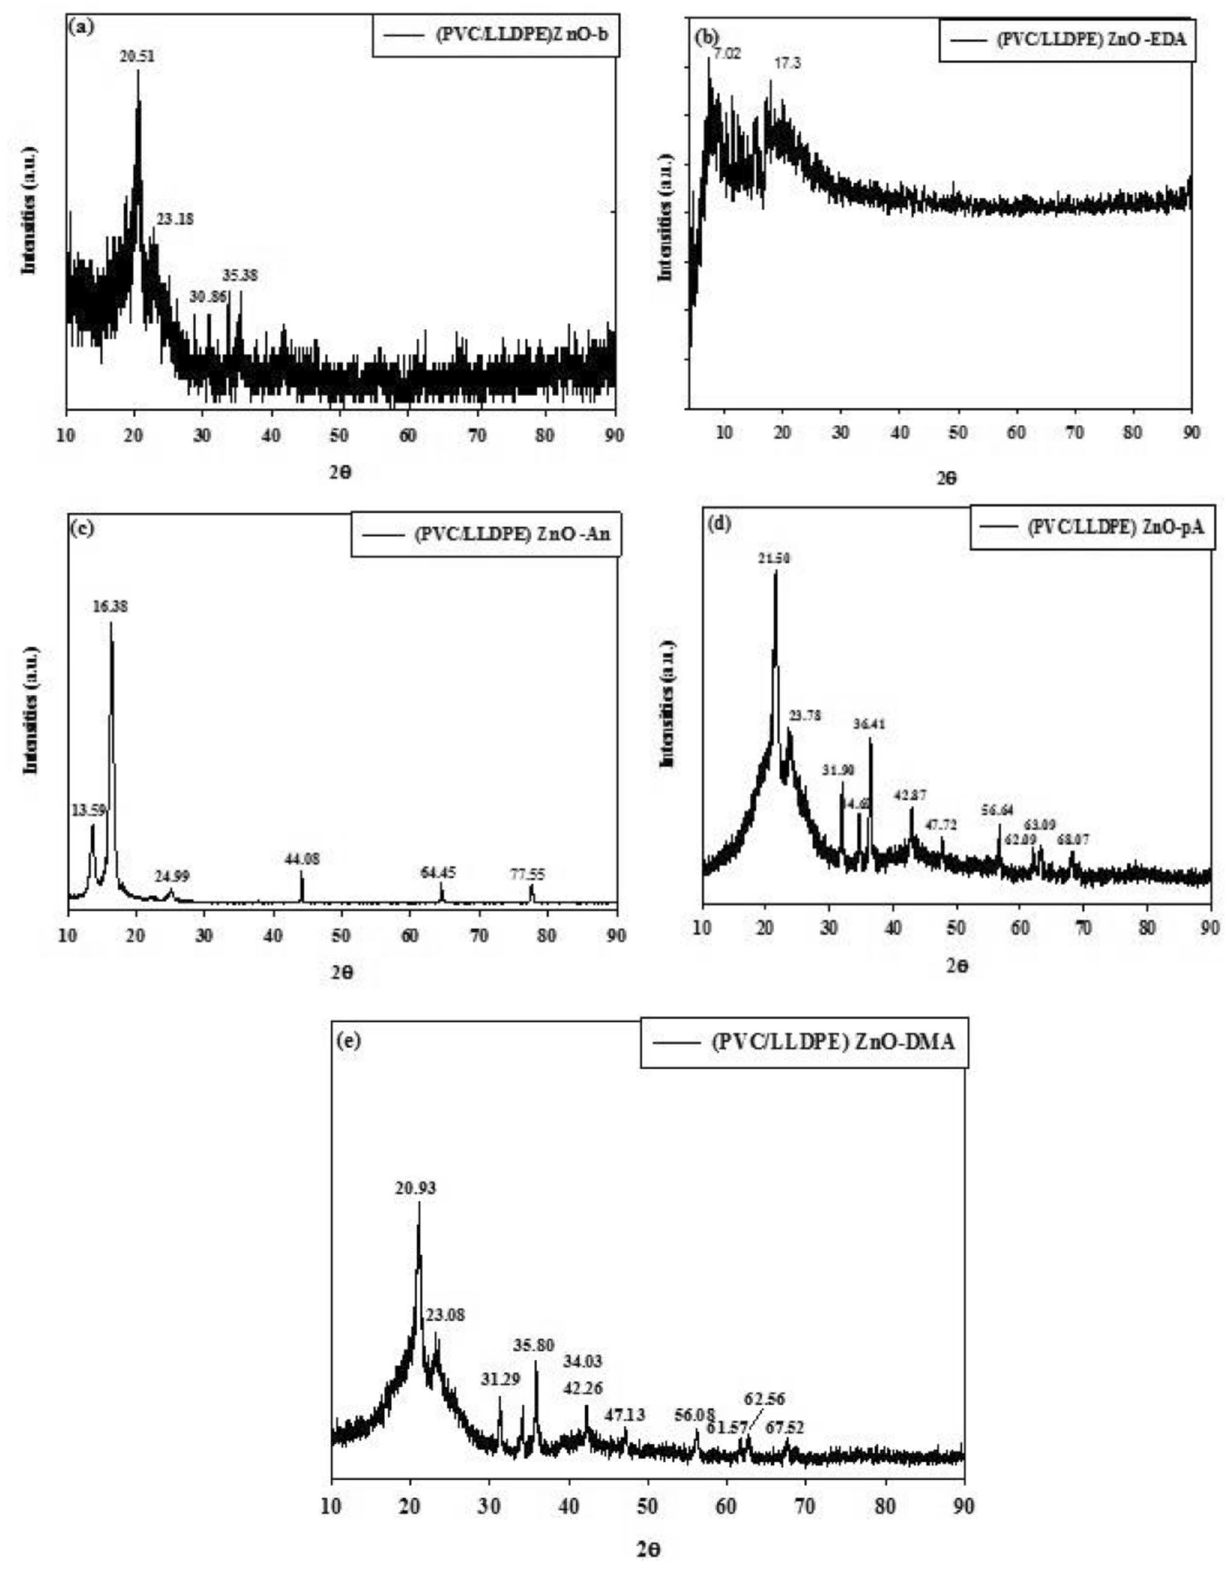
Figure 5. The XRD curves of aminated mopdfied PVC in (PVC/LLDPE)ZnO